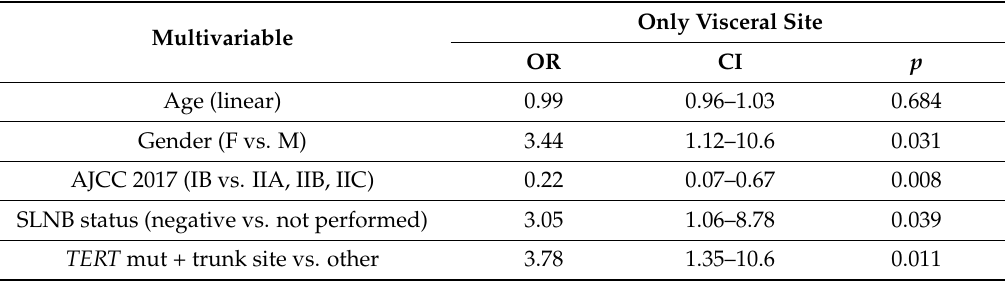
Table 5. Multivariate logistic regression.